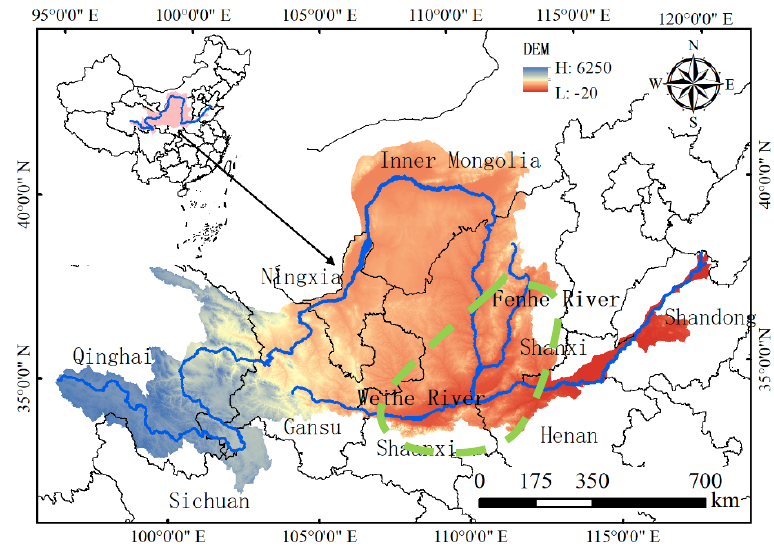
Figure 1. The geographic location of the YRB.